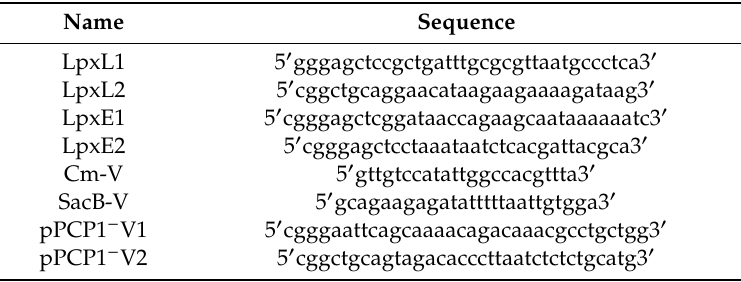
Table 2. Primers used in this